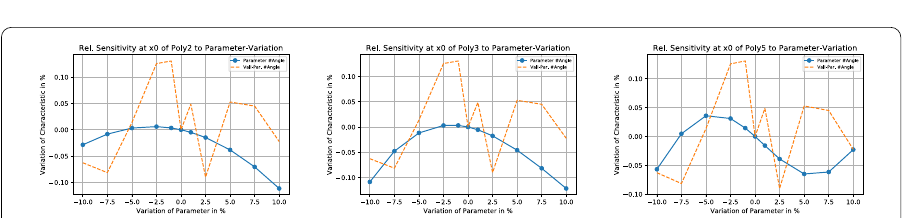
Fig. 20 Sensitivity to Angle-variation for second, third, and fifth oder model